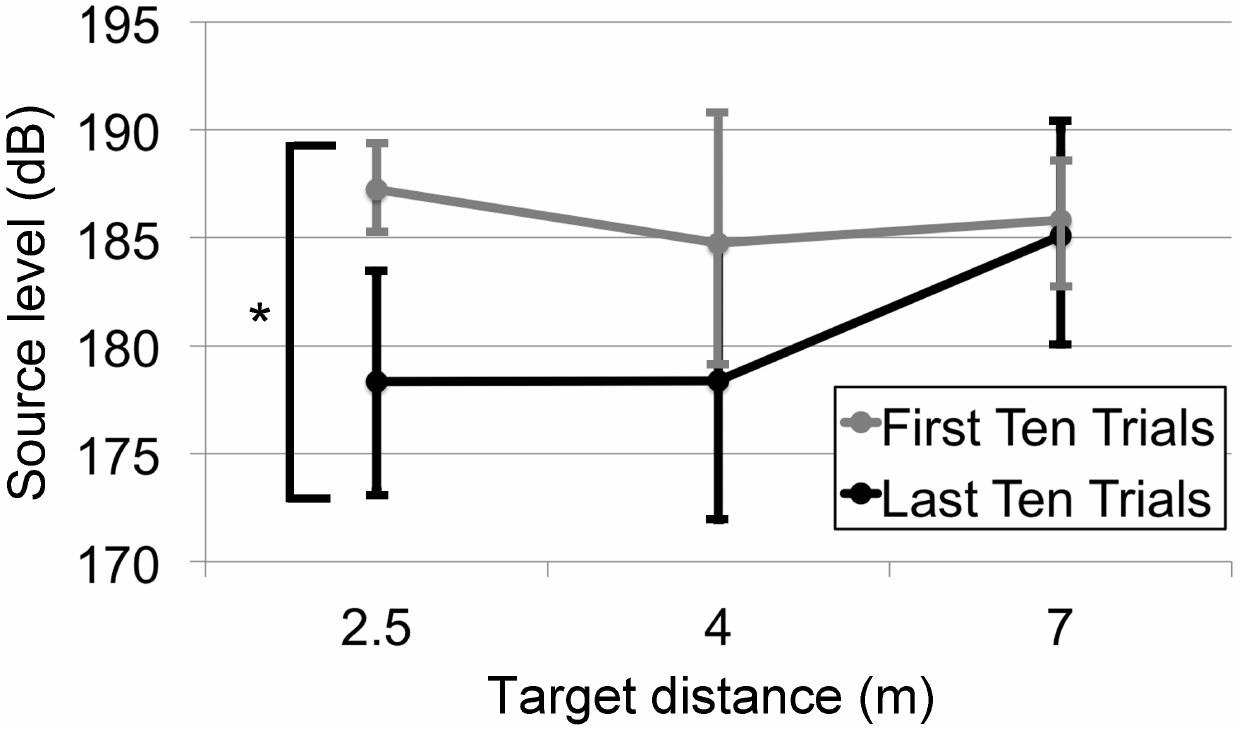
Figure 4. Bootstrapped 95% confidence intervals to demonstrate the effect of learning on initial click source level for the predictable trials. Bootstrapped 95% confidence intervals for the first click between the first ten trials and the last ten trials of each predictable session. Compared to the first ten trials, the dolphin produced significantly ( p , 0.05) lower source levels for the last ten trials at the 2.5 m distance. The dolphin also produced lower source levels for the last ten trials at the 4 m distance, but due to the large variation this change was not significant